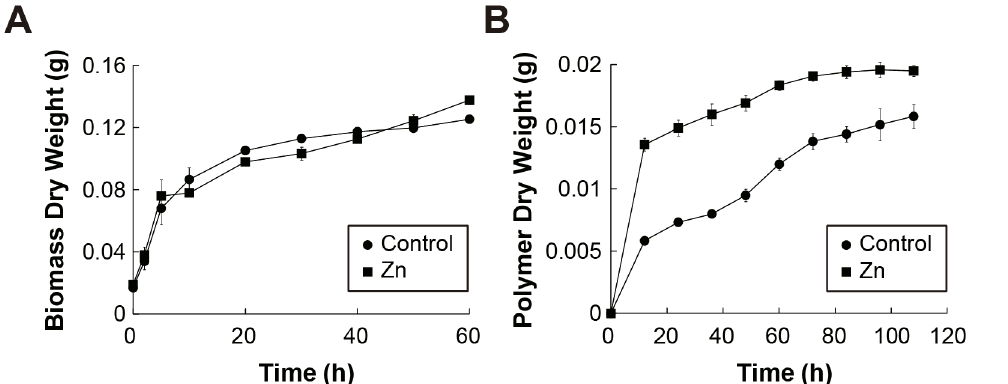
Fig 6. EPS Production Kinetics when Induced with Zn at 0.05 g l -1 . The data shown represent EPS production and Rhodotorula mucilaginosa strain UANL-001L growth in the absence and presence of Zn at different time points. A) Dry biomass of Rhodotorula mucilaginosa strain UANL-001L (g) B) Dry polymer weight